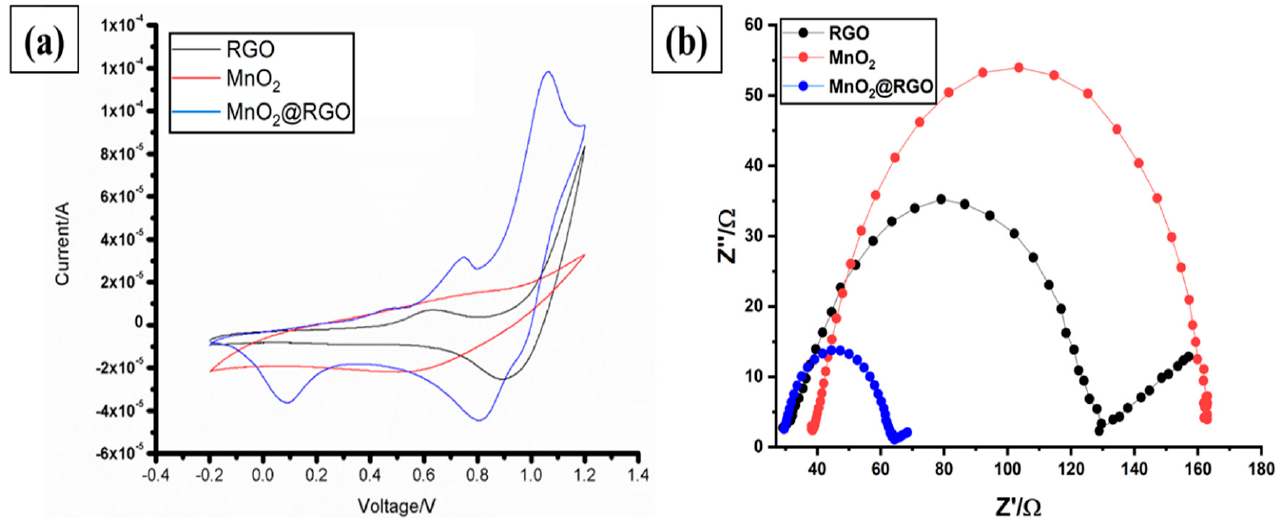
Figure 5. ( a ) CV voltammograms recorded at potential range of − 0.2 to 1.2 V, at a scan rate of 25 mV s − 1 in 0.1 M KCl ( b ) Nyquist EIS plots ( b ) obtained after the electrodeposition of RGO nanosheets, MnO 2 nanoparticles and MnO 2 @RGO nanocomposite on the GCE surface.